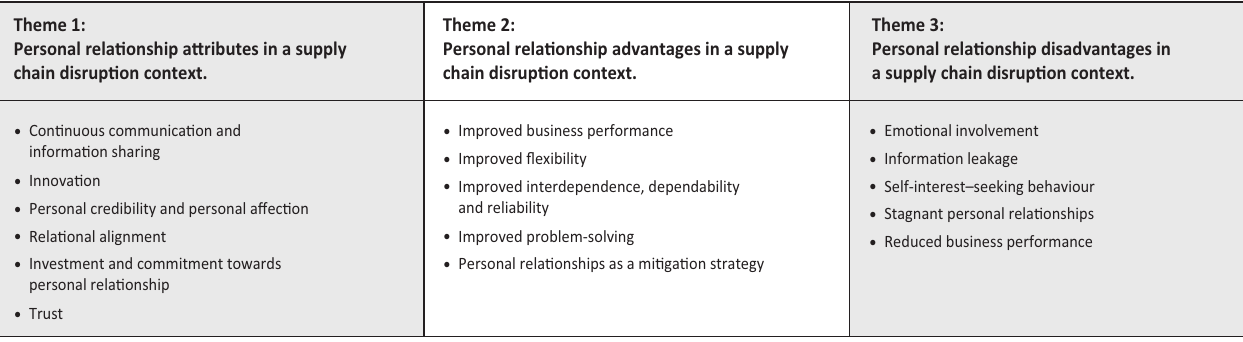
FIGURE 1: Linking the sub-themes to the research